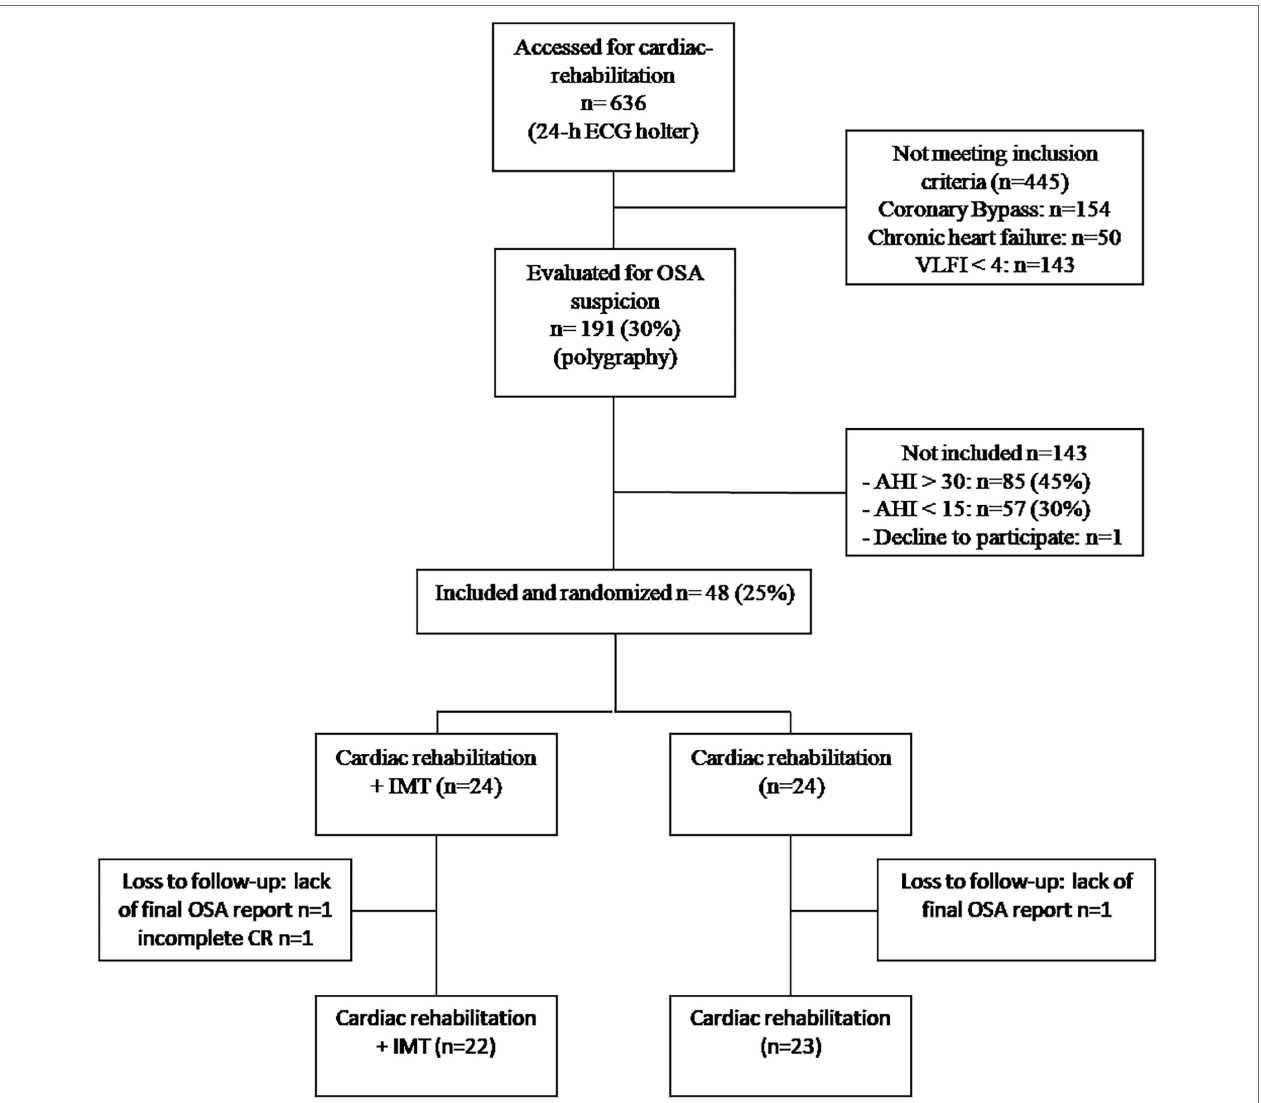
FIGURE 1 | Flowchartof the study. OSA, obstructive sleep apnea; AHI, apnea-hypopnea index; IMT, inspiratory muscle training; CR, cardiac rehabilitation; and VLFI, very low frequency power spectral density of heart rate